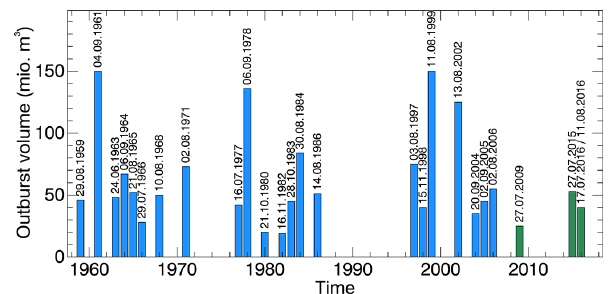
Figure 2. Historical GLOF volumes from Kyagar Glacier since the 1960s. Volumes from 1959 to 2006 are redrawn after Zhang (1992) and Chen et al. (2010). Volumes from 2006 to 2016 are estimated from lake extent on satellite